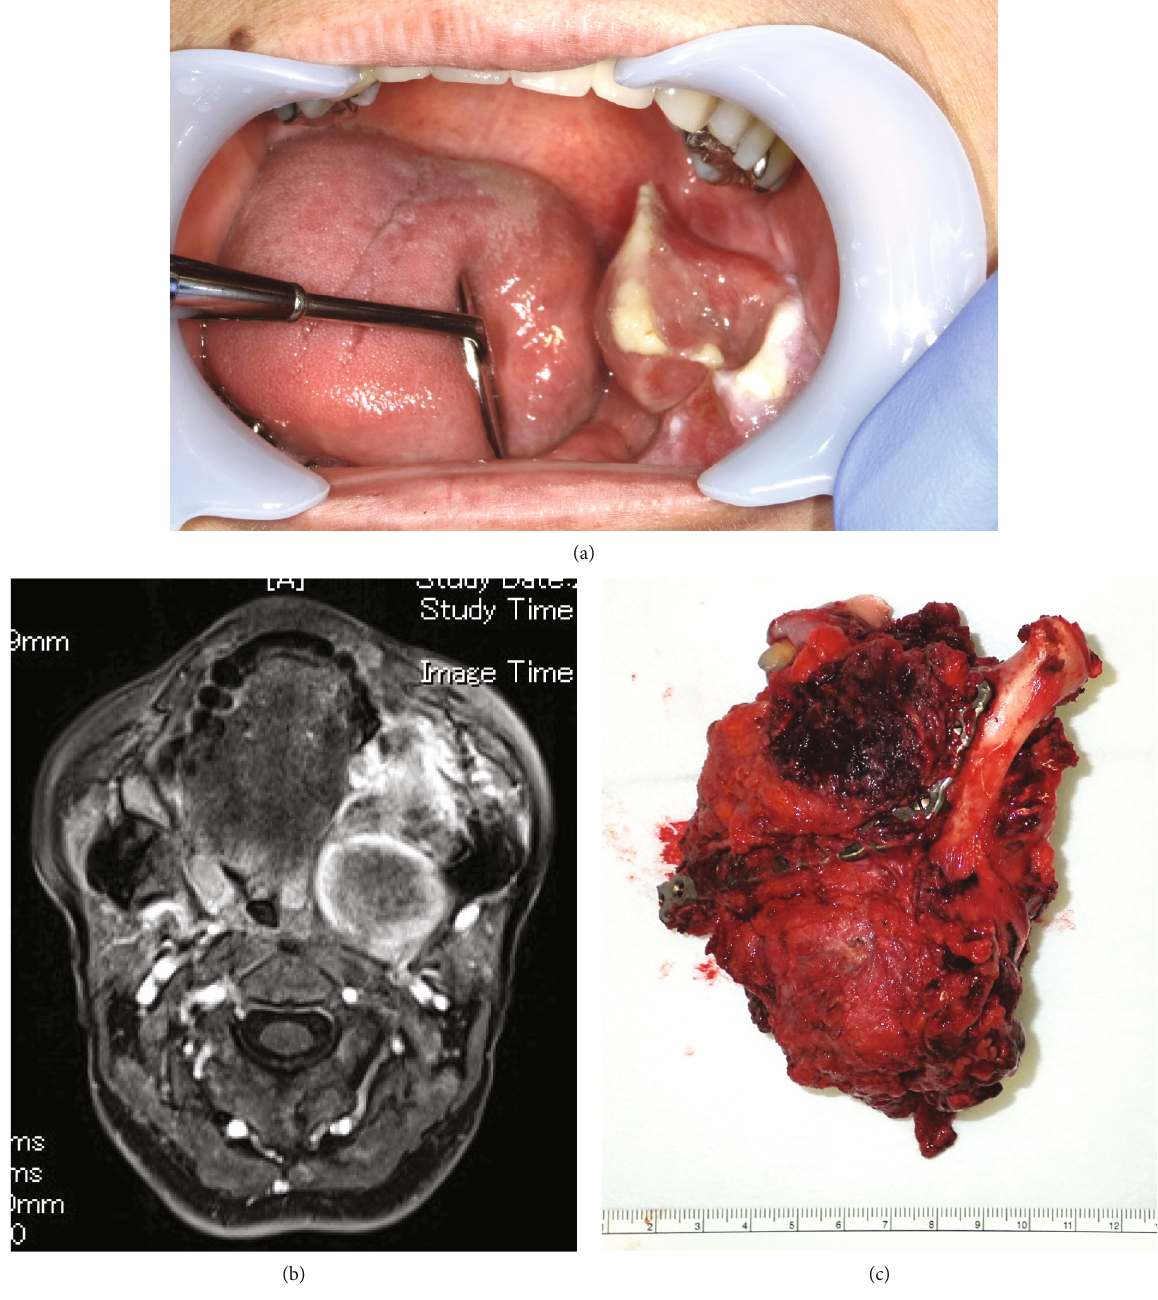
Figure 3: (a) Oral fi ndings for the recurrent tumor. A growing mass is observed at the left posterior part of the mandible showing rapid growth approximately 6 years after the fi rst enucleation. (b) Magnetic resonance image (short-term inversion recovery) depicting a 39 × 64 × 59 mm highly enhanced mass expanding from the left mandible to the parapharyngeal space. (c) The resected